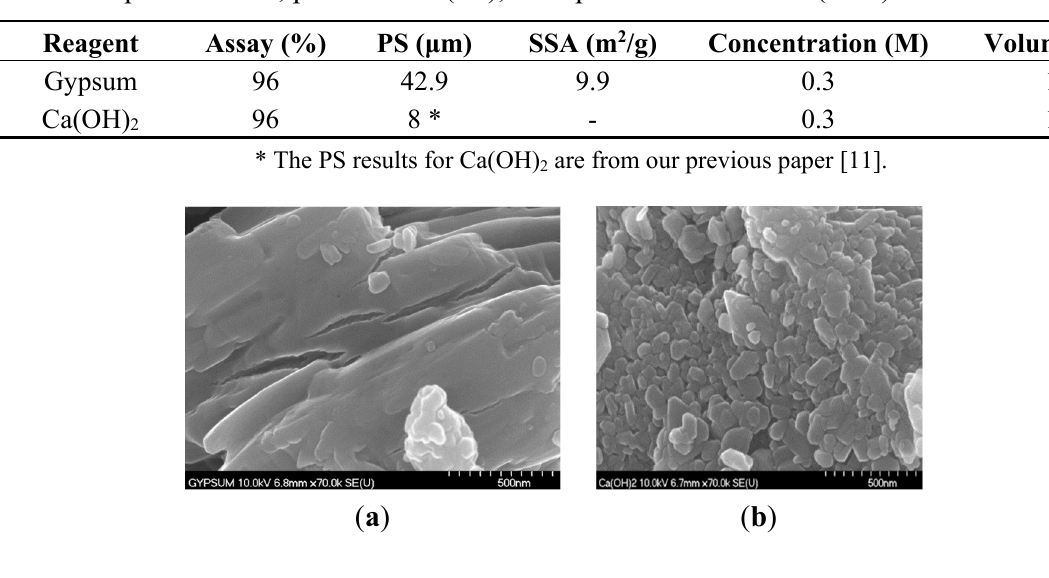
Figure 1. SEM images of the calcium source materials: ( a ) Gypsum and ( b ) Ca(OH) 2